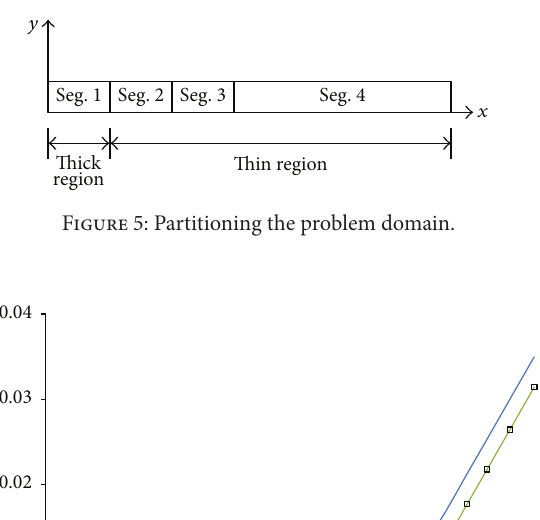
Figure 7: Axial displacement variation along 𝑧 -axis at step ( 𝑥 = 2